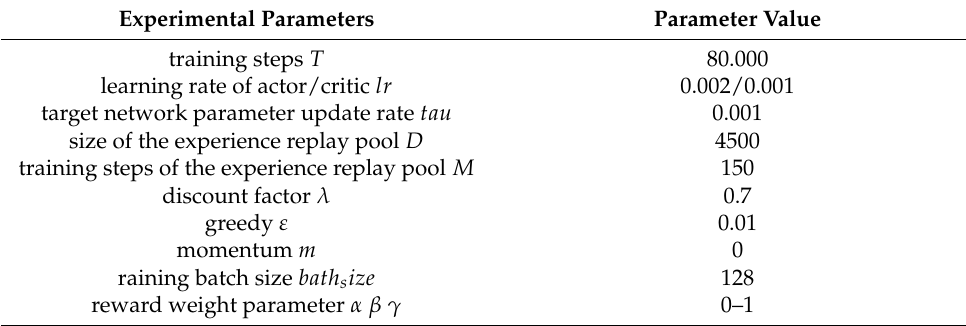
Table 1. Simulation experiment parameters